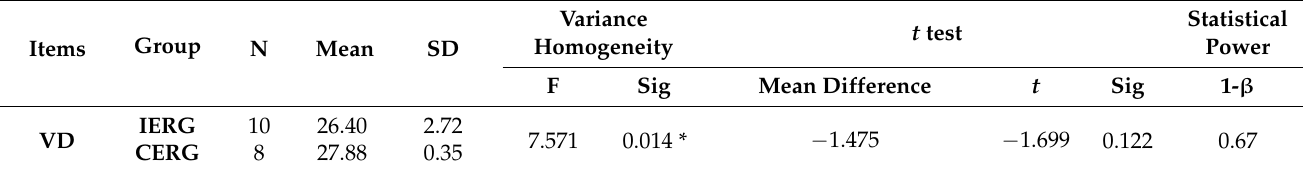
Table 4. Results of the Student’s t test of the sum of valid days between groups and its statistical power.